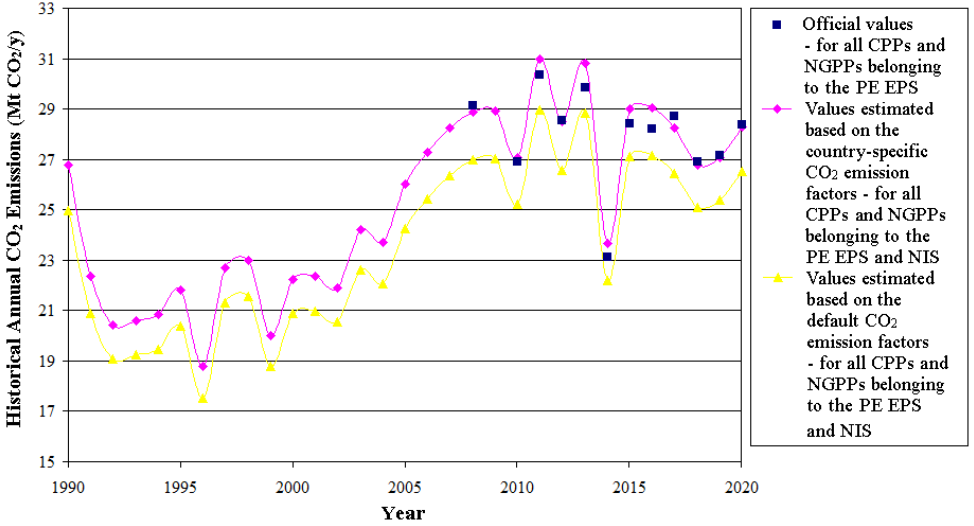
Figure 4. Historical annual CO 2 emissions from Serbian CPPs and NGPPs [6,55,57].